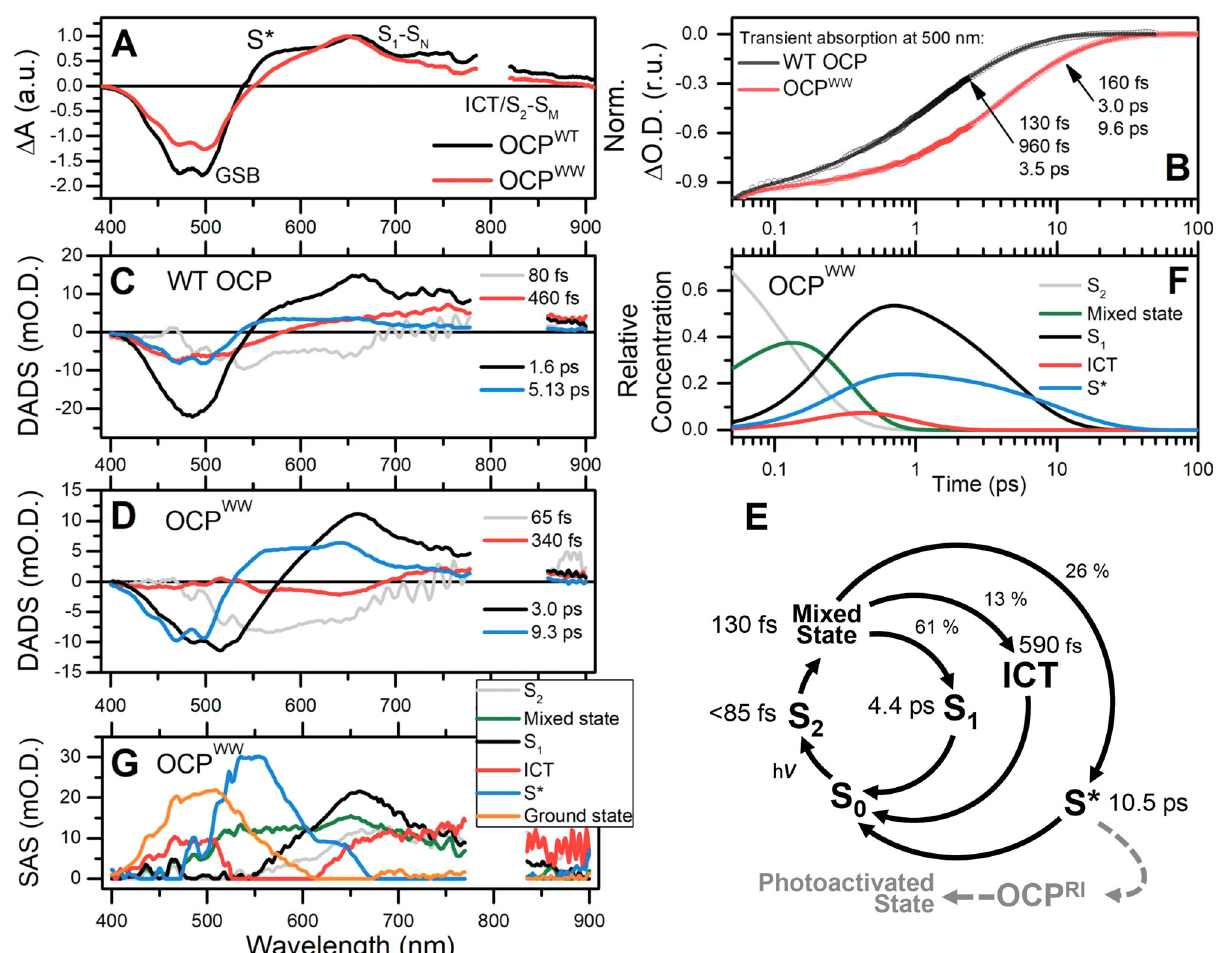
Fig. 3 Excited state dynamics and photochemistry of the ketocarotenoid in OCP as revealed by transient absorption spectroscopy. A Transient absorption spectra of WT OCP (black) and OCP WW (red). Spectra were recorded 1 ps after excitation with a 30-fs pulse at 520 nm for WT OCP and OCP WW . Spectra were normalized to the maximum of the ESA bands. B Time courses of transient absorption of WT OCP (black) and OCP WW (red) measured at 500 nm probe wavelength. Numbers indicate the characteristic lifetimes of the corresponding states. Note the logarithmic timescale. C , D Decay-associated difference spectra (DADS) obtained from global fi tting of the transient absorption spectra of WT OCP and OCP WW , respectively. E The model of transitions between the states of ECN in OCP after photoexcitation. Numbers indicate characteristic lifetimes of the corresponding states. OCP RI represents a long-lived “ red intermediate ” OCP state, in which the protein structure is compact, while the conformation of the carotenoid is (quasi-) stabilized in a state with an increased conjugation length due to breakage of hydrogen bonds to the amino acid residues in the CTD. The following dashed arrow indicates possible slow transitions of OCP RI into the physiologically active state OCP R . F Relative concentration kinetics of the states generated by a 26 fs pulse in OCP WW and corresponding species-associated spectra (SAS) of the states ( G ) obtained from target analysis of transient absorption spectra of OCP WW considering the model ( E